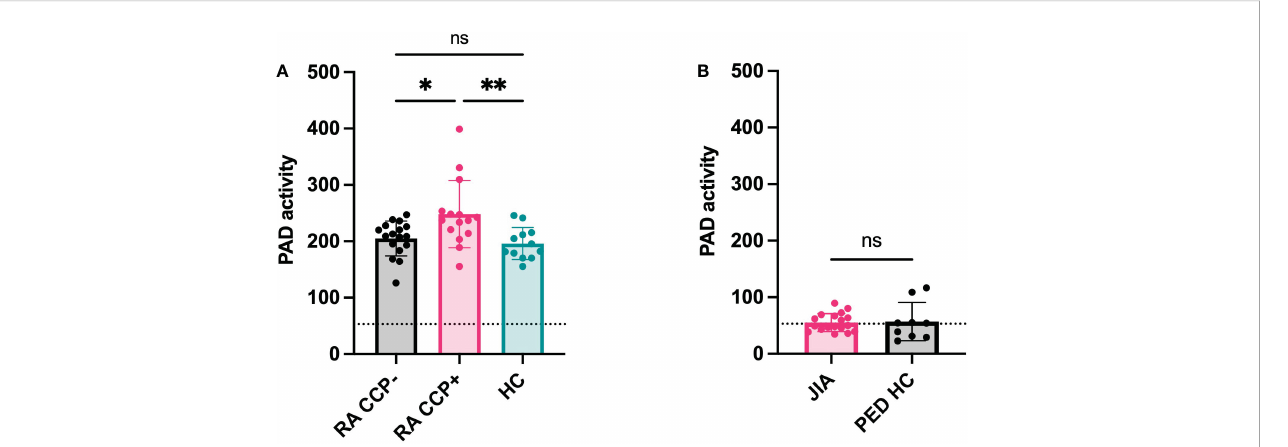
FIGURE 6 Systemic citrullination in anti-cyclic citrulline antibody positive RA patients. PAD activity was detected in sera of anti-cyclic citrulline peptide antibody (CCP) positive Rheumatoid Arthritis (RA) patients (n=15) and anti-CCP negative RA patients (n=17) and compared to healthy subjects (n=12) (A) . In parallel, PAD activity was measured in plasma of Juvenile Idiopathic Arthritis (JIA) patients (n=18) and compared with plasma of healthy pediatric controls (n=9) (B) . An Evans blue quencher concentration of 55 µM and 75 m M were used for serum and plasma detection, respectively, in combination with a TAMRA-(GRGA) 4 substrate concentration of 0.5 µM. Error bars show min to max value, center values represent median value. Signi fi cance considered * for p<0.05, ** for p<0.01 by one-way ANOVA Tukey ’ s multiple comparisons test for RA samples and Mann-Whitney test for JIA samples. Detection limit in sera determined by EDTA treatment and represented by dotted line (71 D RFU/min for sera, 53 D RFU/min for plasma). ns, not signi fi